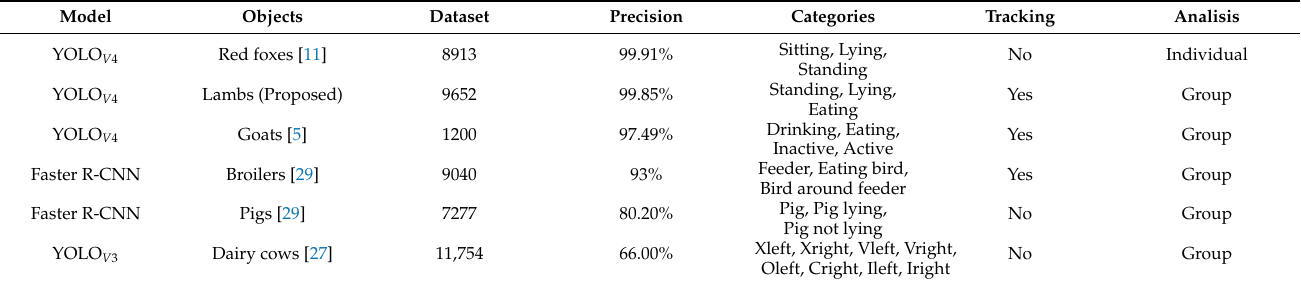
Table 6. Comparison with related